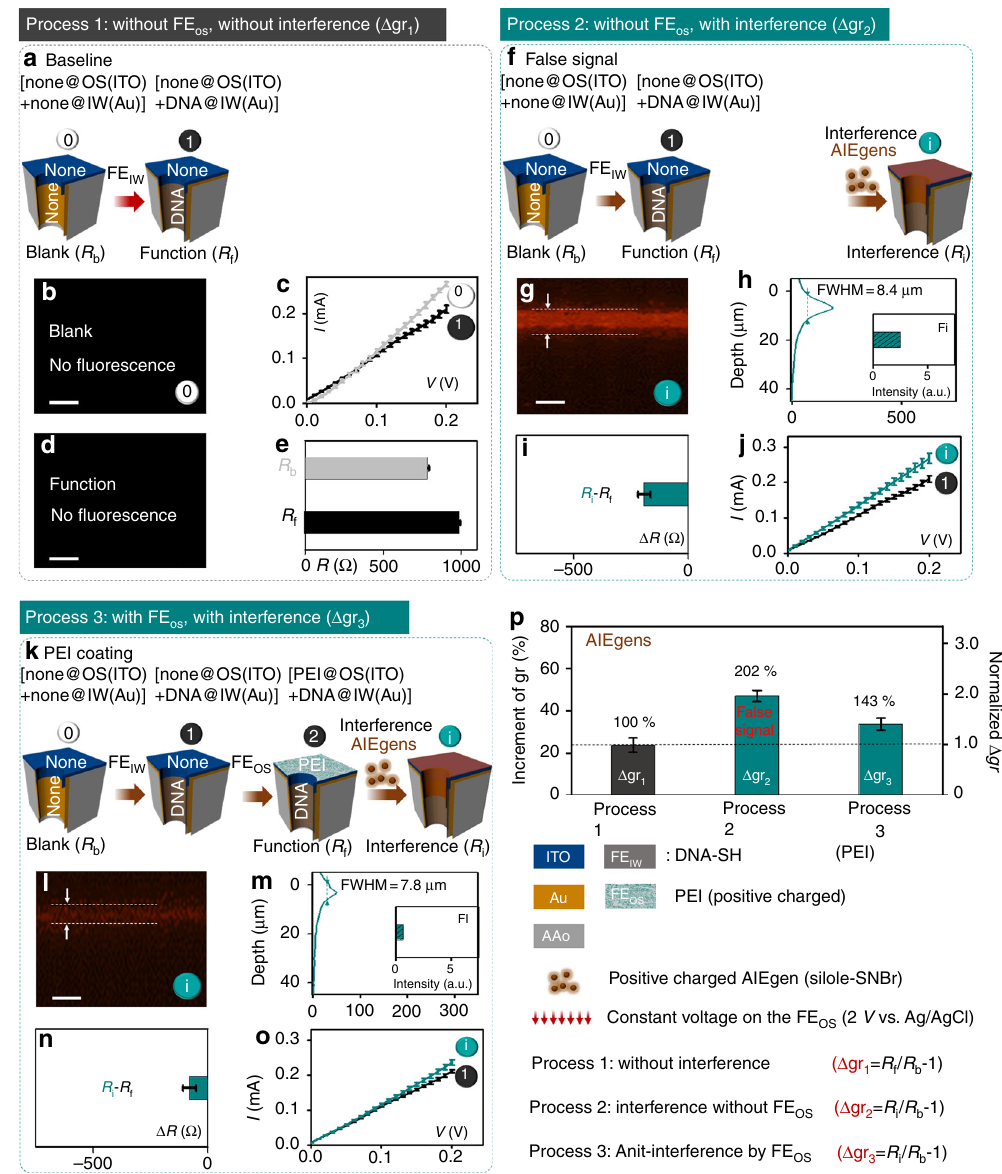
Fig. 6 The chosen FE OS endowing OS with the function, anti-interference. The FE OS is positive molecular. Three different processes (Process 1 ( a ), 2 ( f ) and 3 ( k )) were conducted to evaluate whether the FE OS , we chosen, bring OS the anti-interference ability. AIEgen is chosen as the interference molecule. [none@OS(ITO) + none@IW (Au)] in a are in the 0 state in Process 1 . [none@OS(ITO) + DNA@IW (Au)] in f are in the 1 state in Process 2. [PEI@OS (ITO) + DNA@IW (Au)] in Fig. 6k are in the 2 state in Process 3. Fluorescent images ( b , d , g , l ), fl uorescent pro fi le ( h , m ), resistances increment ( e , i , n ), I – V curves ( c , j , o ) are corresponding to the steps in Process 1, 2 and 3, respectively. p Comparison of the Δ gr from the three processes mentioned above, and the de fi nition for them: Δ gr 1 = R f / R b − 1 (for Process 1); Δ gr 2 = R i / R b − 1(for Process 2); Δ gr 3 = R i / R b − 1(for Process 3). Scale bars, 10 μ m. Error bars represent standard deviations of the measured samples. Five experimental replicates for each